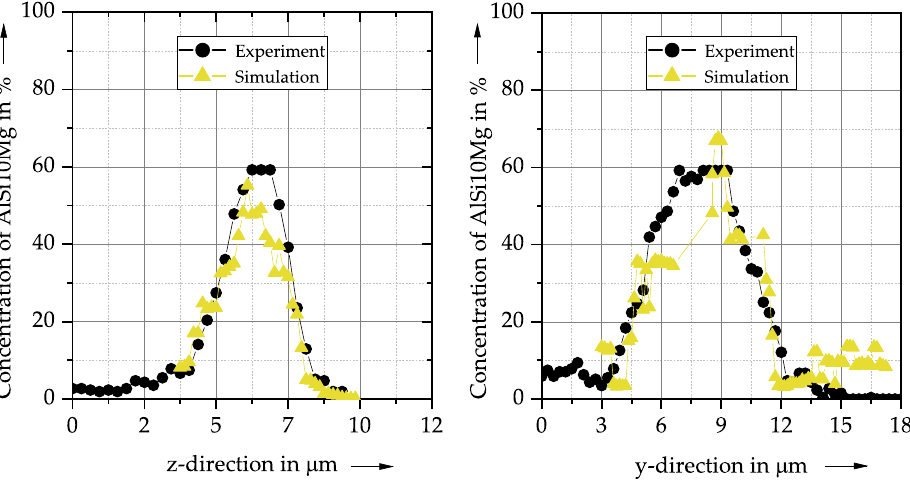
Figure 7. Comparison of the simulation and the experimental results of the mixing behavior for a single AlSi10Mg powder particle after single-track melting in two spatial